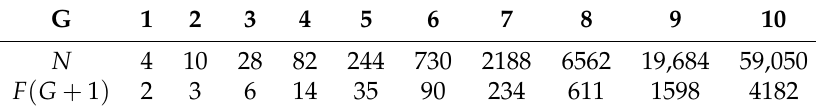
Table 1. Comparison of N and F ( G + 1 ) for the first ten generations of T-fractals.